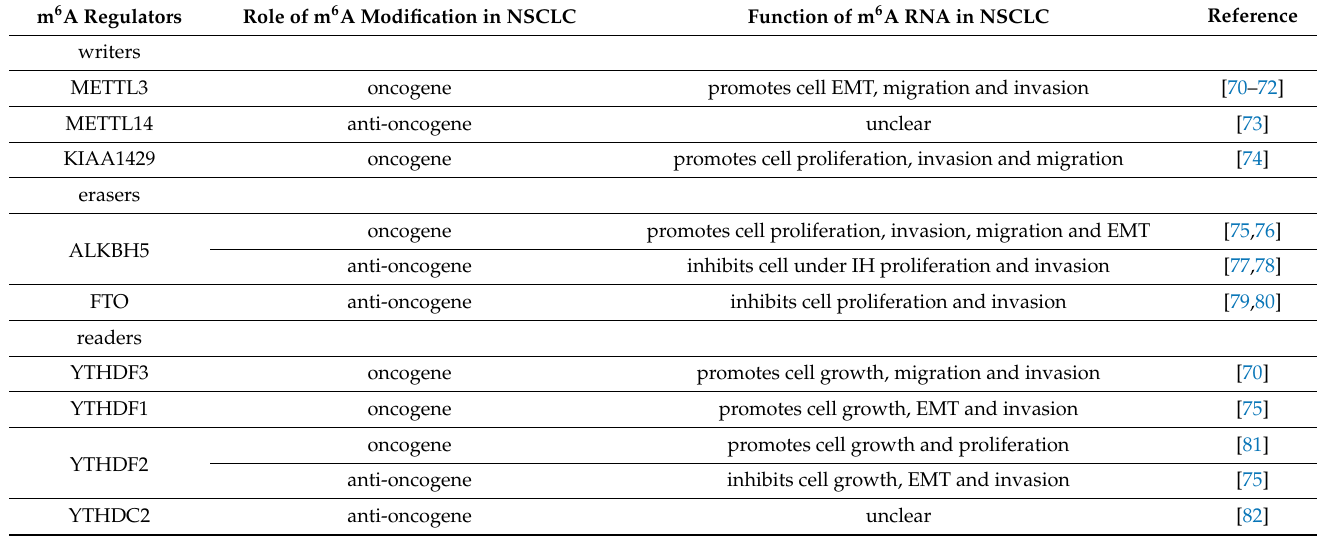
Table 2. Dual effects of m 6 A mRNA modification on non-small cell lung cancer (NSCLC).